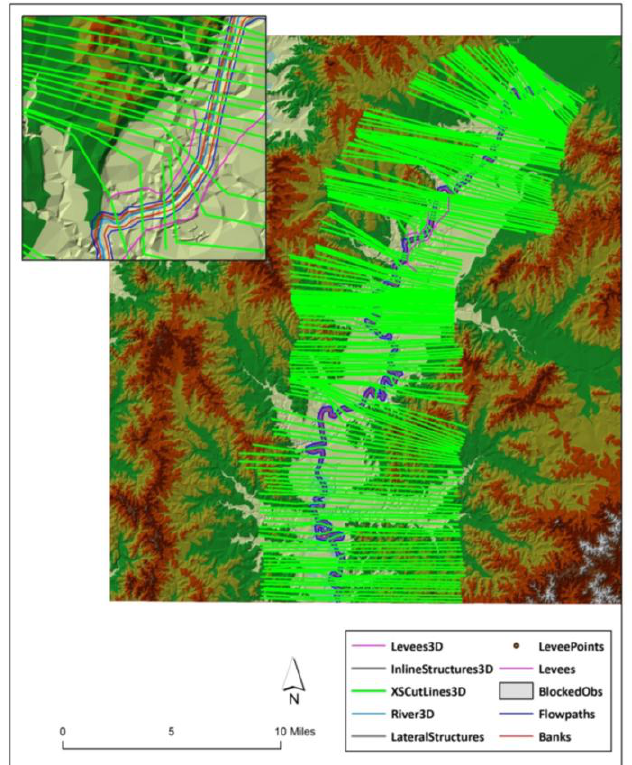
Figure 5. Preprocessing of geospatial RAS